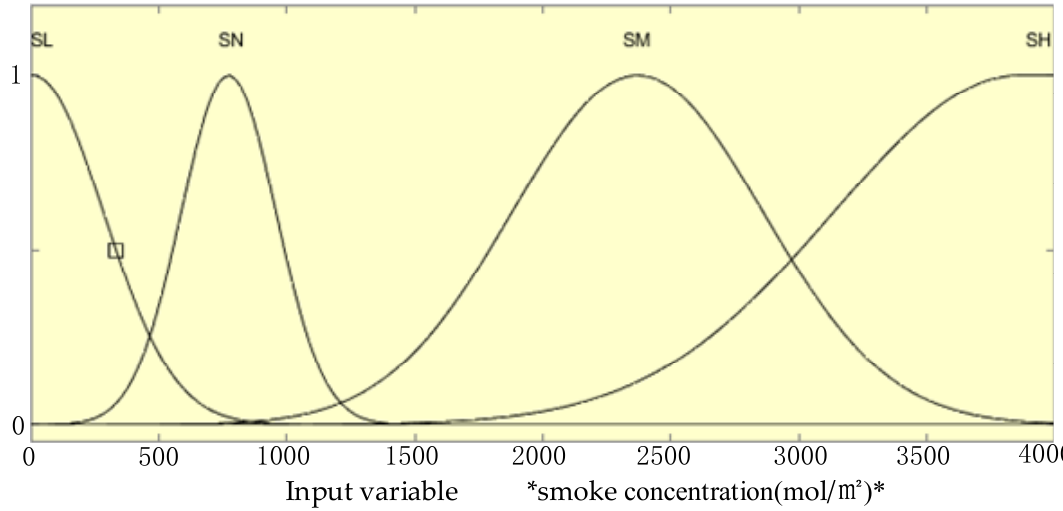
Figure 12. The smoke concentration belongs to the function graph.